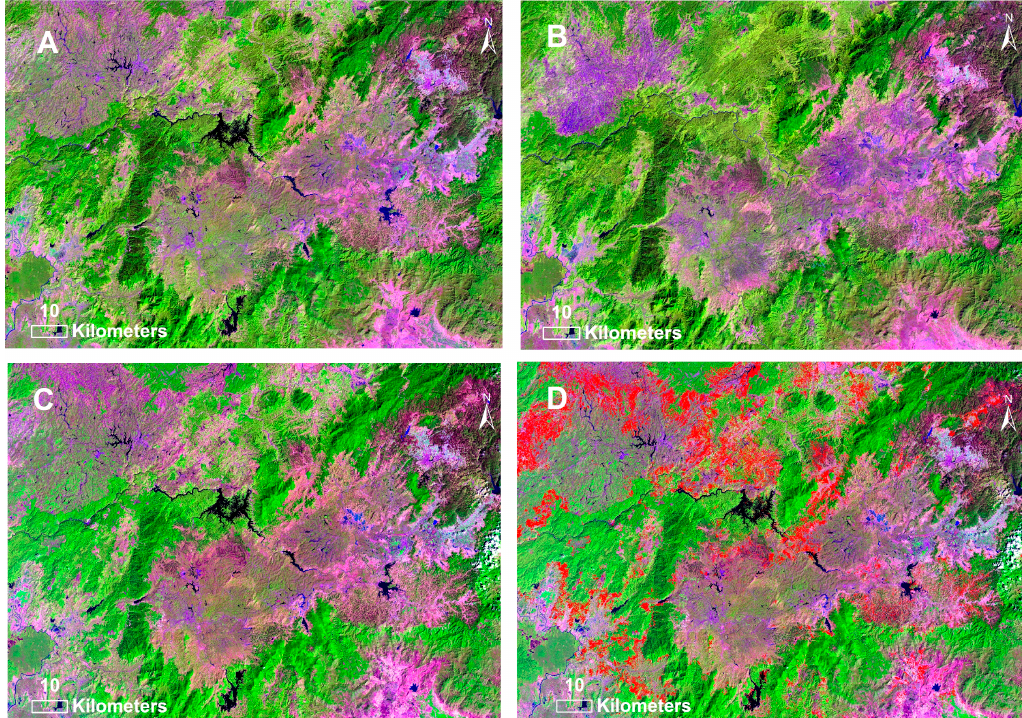
Figure 5. Landsat imagery showing a portion of Lam Dong Province (same area as shown in Figure 2). ( A ) = Synthetic image, January 2014; ( B ) = Synthetic image, January 2000; ( C ) = Actual image, 15 February 2014; ( D ) = Global forest change product showing forest loss from 2000 through 2014 in red [35] overlain onto 15 February 2014 image.